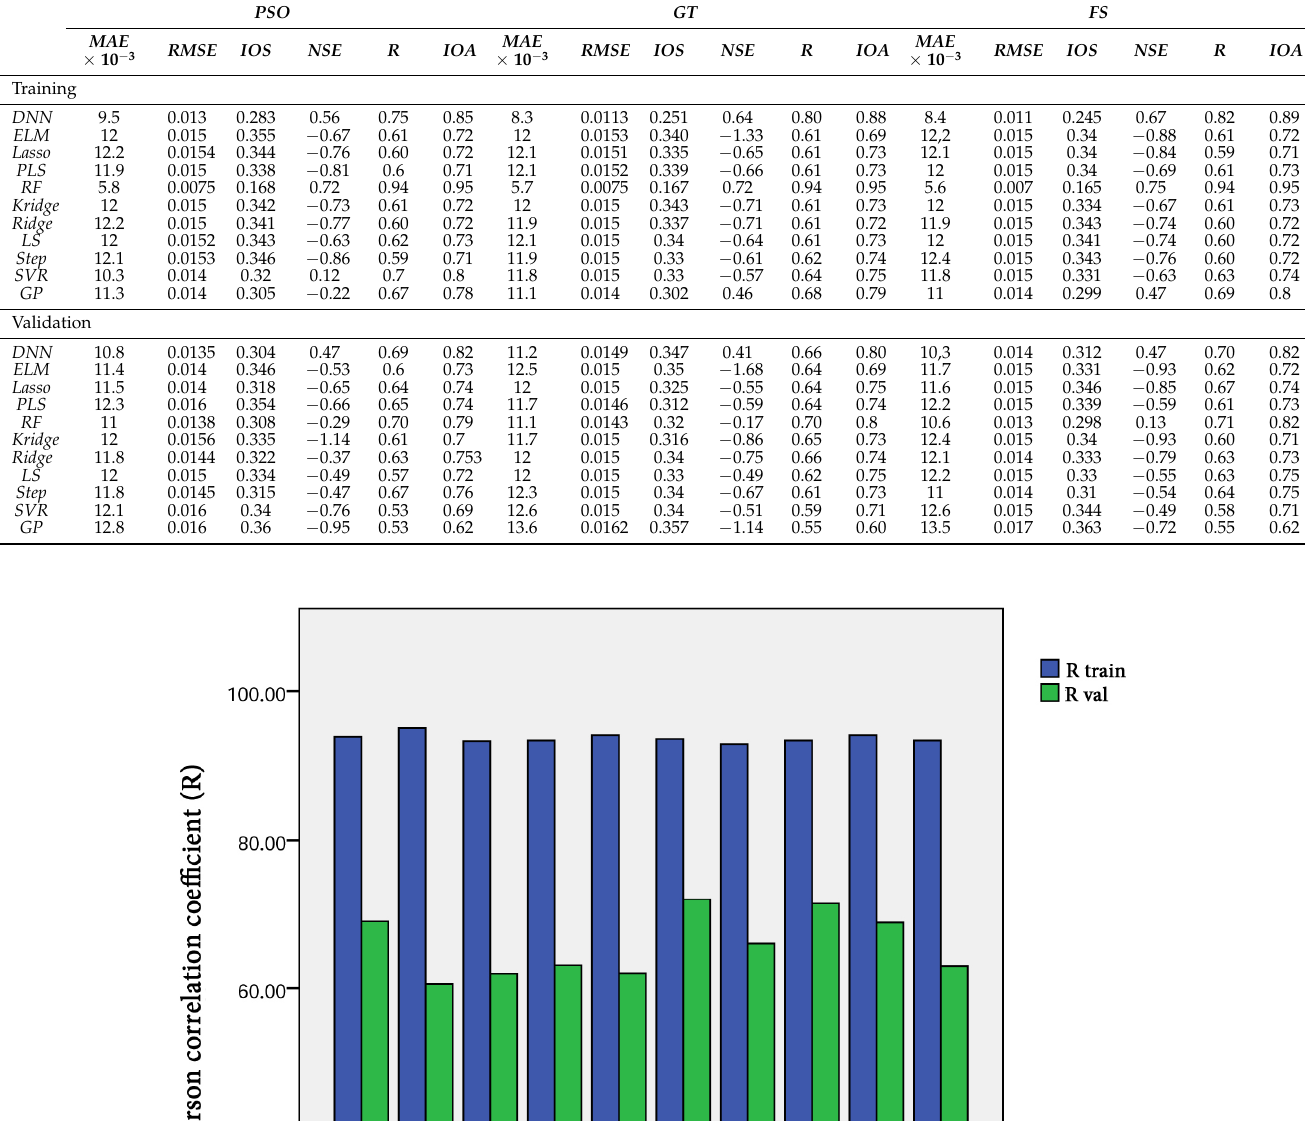
Table 10. Performance indicator values of AI models for predicting the Swelling index.